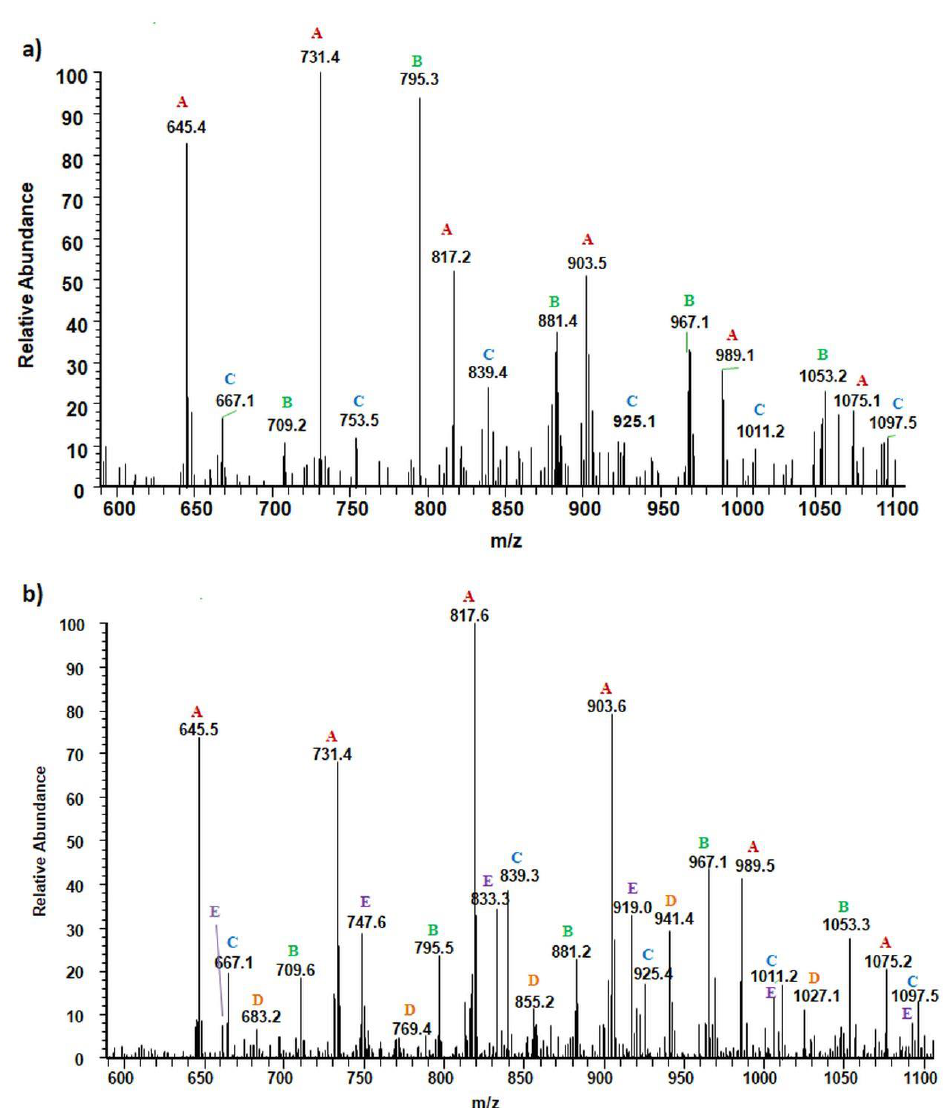
Figure 3. Spectral expansion in the range m / z 600–1100 of ESI-mass spectra (performed in negative ion-mode) of water solution of the [(p-AA-CH 2 -HP) x -co-(HB) y ] (co)oligoesters collected before incubation (sample 2) ( a ) and aqua-soluble degradation products collected after hydrolytic degradation (14 days) of the [(p-AA-CH 2 -HP) x -co-(HB) y ] (co)oligoesters at 37 °C ( b ).